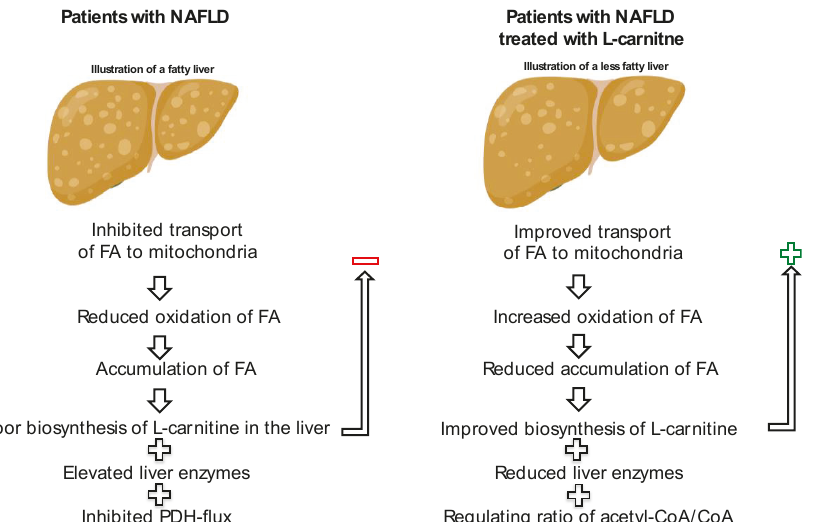
Figure 3. Simplified schematic of the processes in Non-Alcoholic Fatty Liver Disease (NAFLD) with and without L-carnitine treatment. Left is an illustration of a fatty liver, where there is reduced oxidation